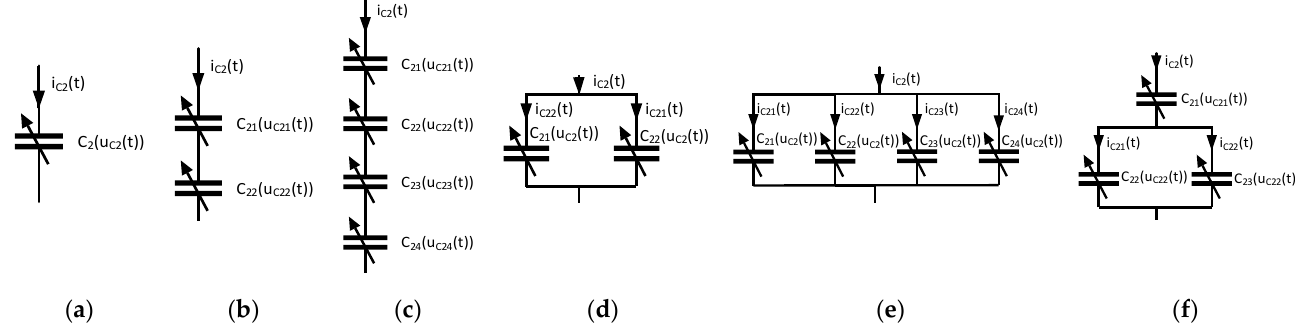
Figure 4. Circuit topologies of voltage-dependent ceramic capacitors with: ( a ) one capacitor; ( b ) two series-connected capacitors; ( c ) four series-connected capacitors; ( d ) two parallel-connected capacitors; ( e ) four parallel-connected capacitors; ( f ) one capacitor connected in series to two parallel-connected capacitors.